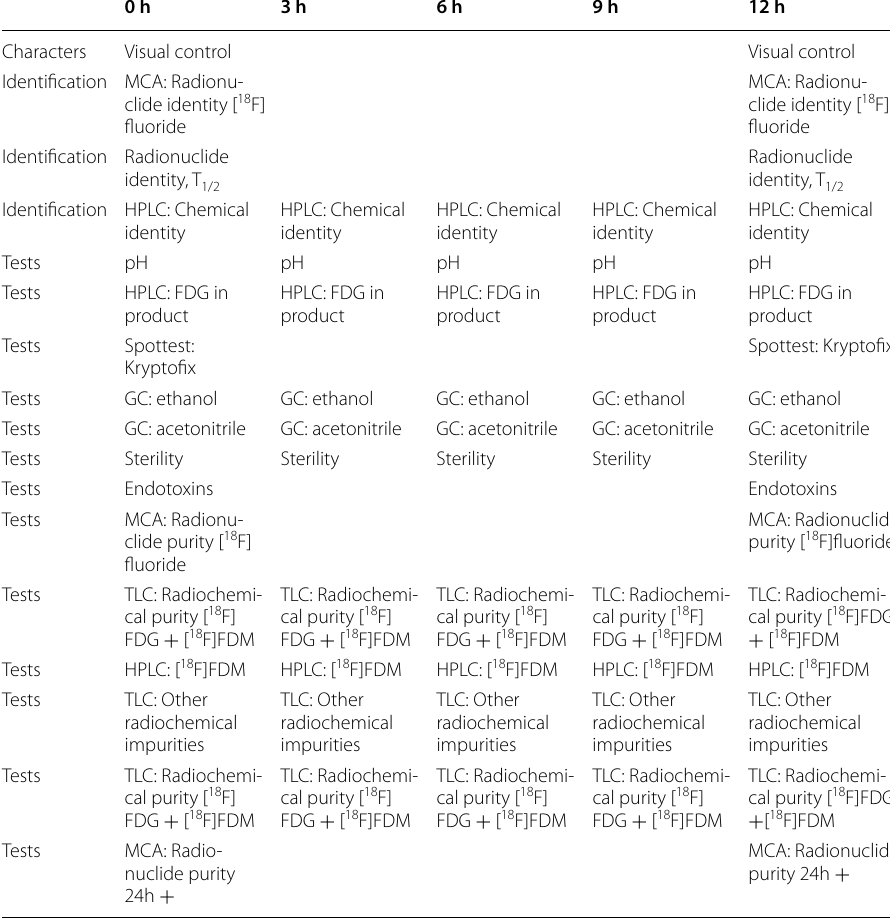
Table 5: List of QC stability tests performed at the two production sites. 0 h